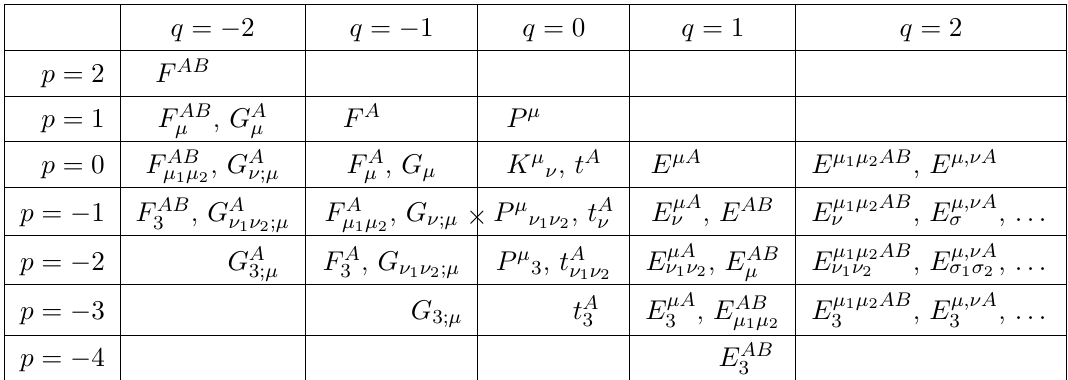
Table 3 . Part of the tensor hierarchy algebra T decomposed under gl (3) (cid:8) e 8 . The subalgebra at p = 0 is the extension of e 11 . The components of fixed p (the rows) are in e 11 representations. The cross marks the fixed point of a reflection symmetry explained in the text. The notation and structure here is similar to that of table